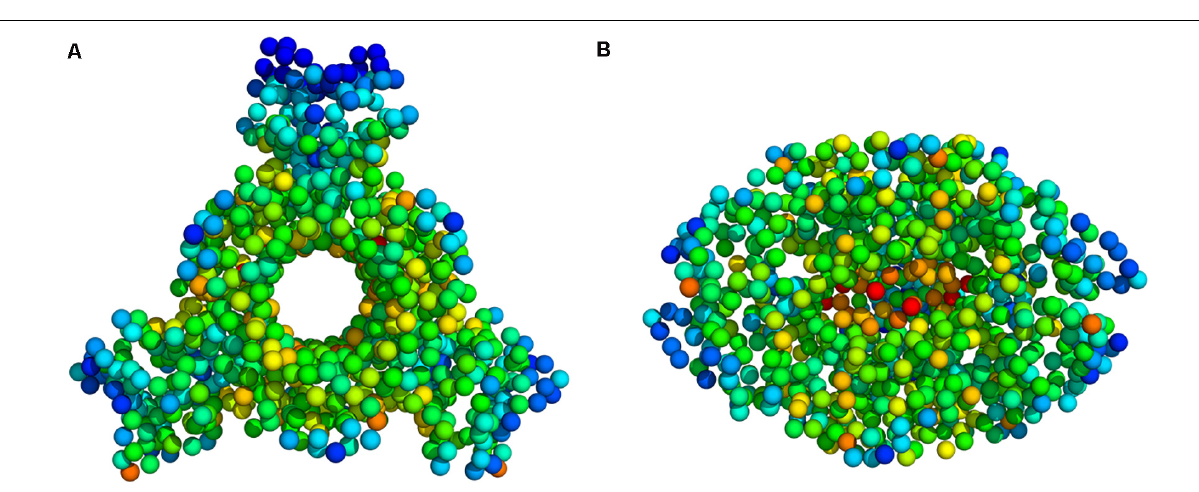
FIGURE 5 | Deformation energy values mapped onto the PTPS 3D structure (A) Top view (B) Side view. The colors of the atoms indicate the amount of deformation. The dark blue regions are the least deformed, whereas red areas are strongly